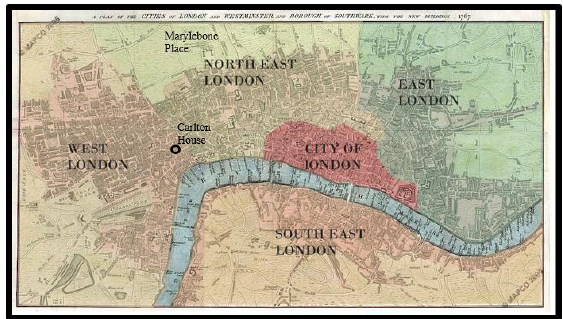
Figure 2: Anonymous (1802) A new Plan of London. (URL